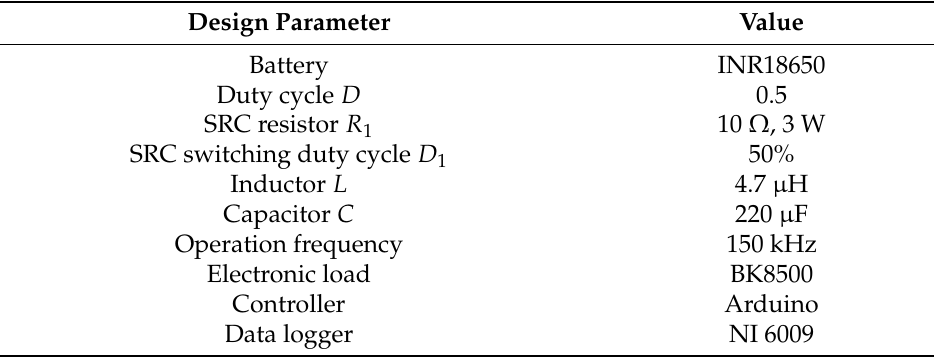
Figure 5. Experimental bench. Table 3. Main specification of the experimental